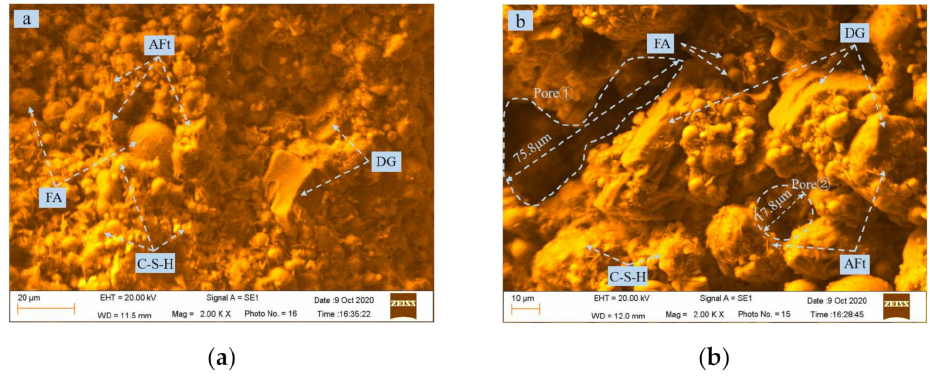
Figure 11. SEM of CBC samples (C/SW ratio was 1:08). ( a ) Gypsum: 10 wt. %, FA: 50 wt. % and SS: 40 wt. %; ( b ) Gypsum: 20 wt. %, FA: 40 wt. % and SS: 40 wt.